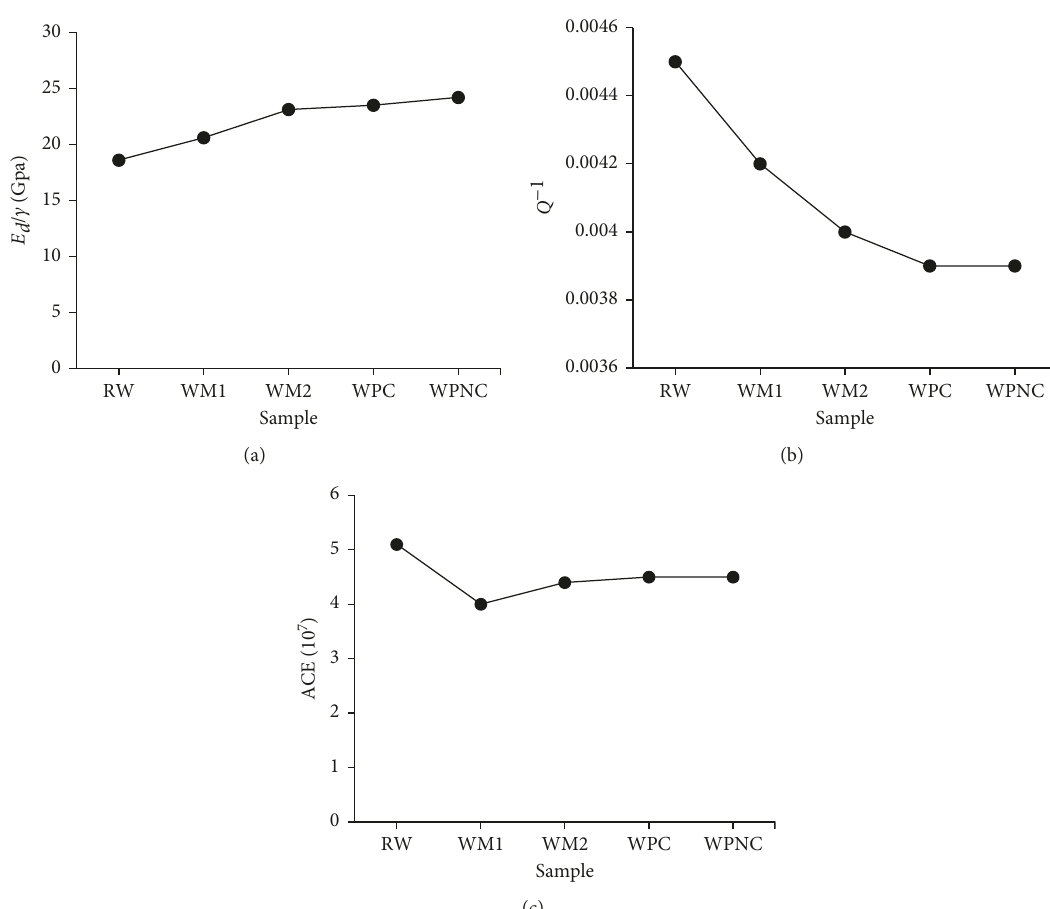
Figure 3: The specific dynamic Young’s modulus ( E and polymerized Kayu Malam